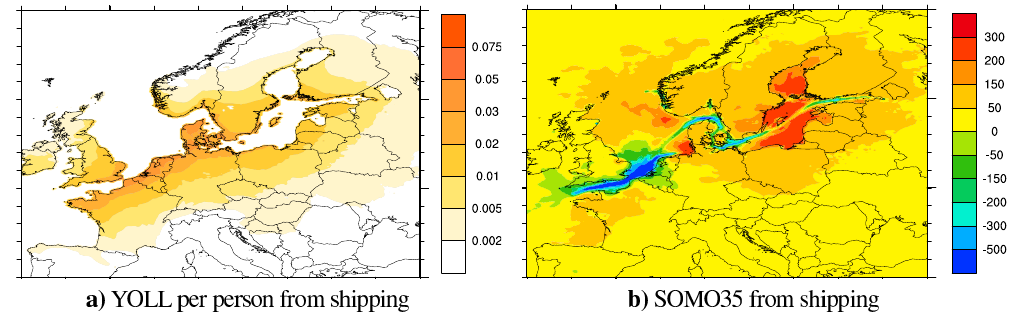
Figure 5. YOLL per person (left) and SOMO35 (right) from year 2009 shipping in the Baltic Sea and the North Sea. Contributions from ship emissions are calculated as reference run minus the model run that excludes ship emissions.